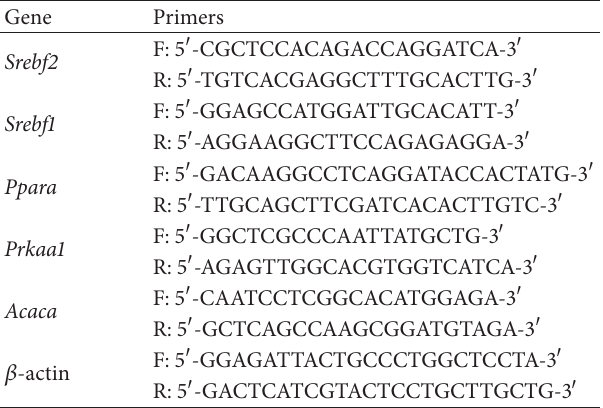
Table 1: Primers used in the polymerase chain reaction.